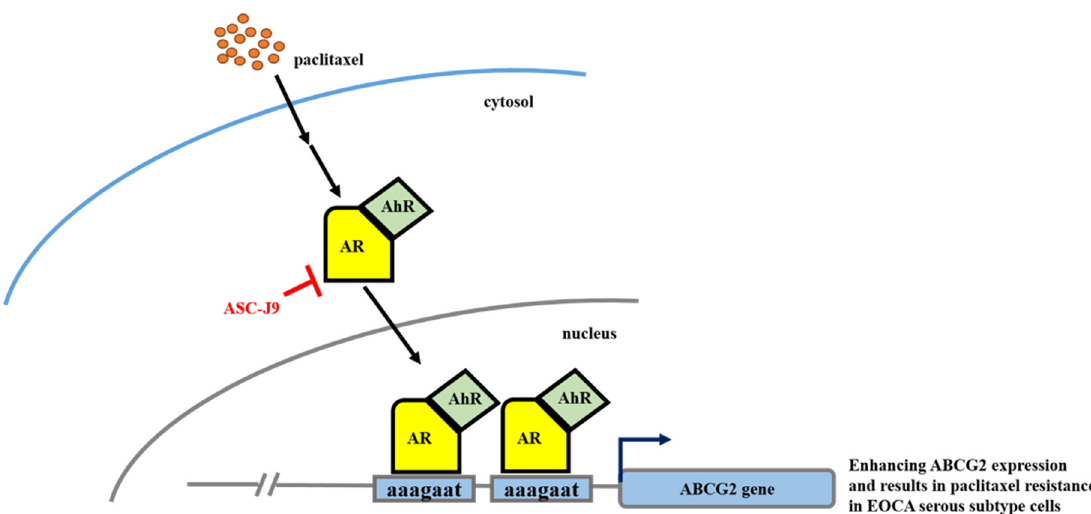
/ AhR–ABCG2 regulatory axis in serous